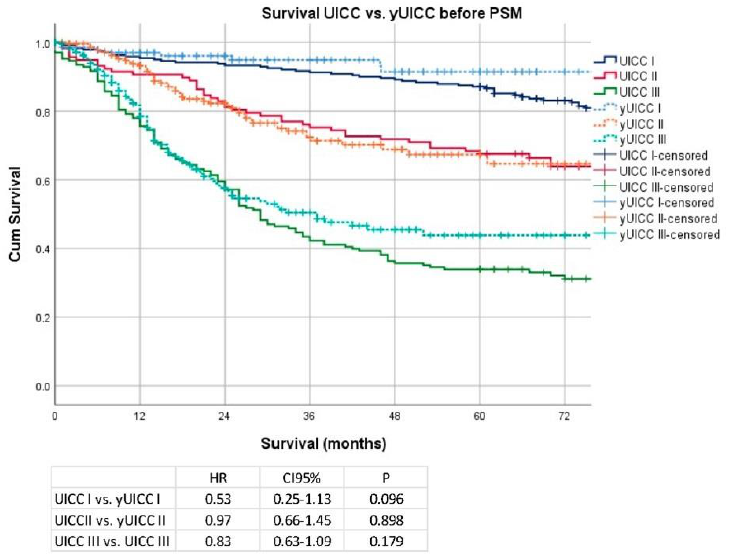
Figure 1. Kaplan–Meier analyses according to UICC/yUICC stages before propensity score matching (PSM). Figure 1. Kaplan – Meier analyses according to UICC/yUICC stages before propensity score match- ing (PSM). Analyzing individual pT stages, only stage pT1 vs. ypT1 (median OS 177 months vs.